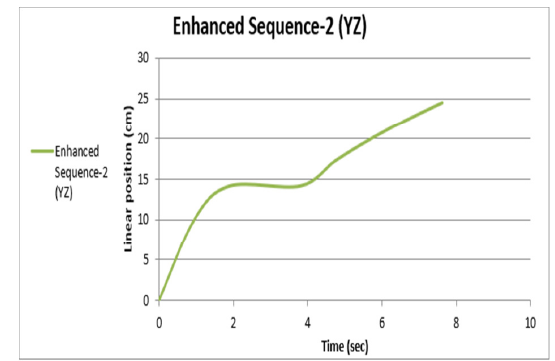
Fig. 13. Enhanced sequence (YZ) for the first obstacle.